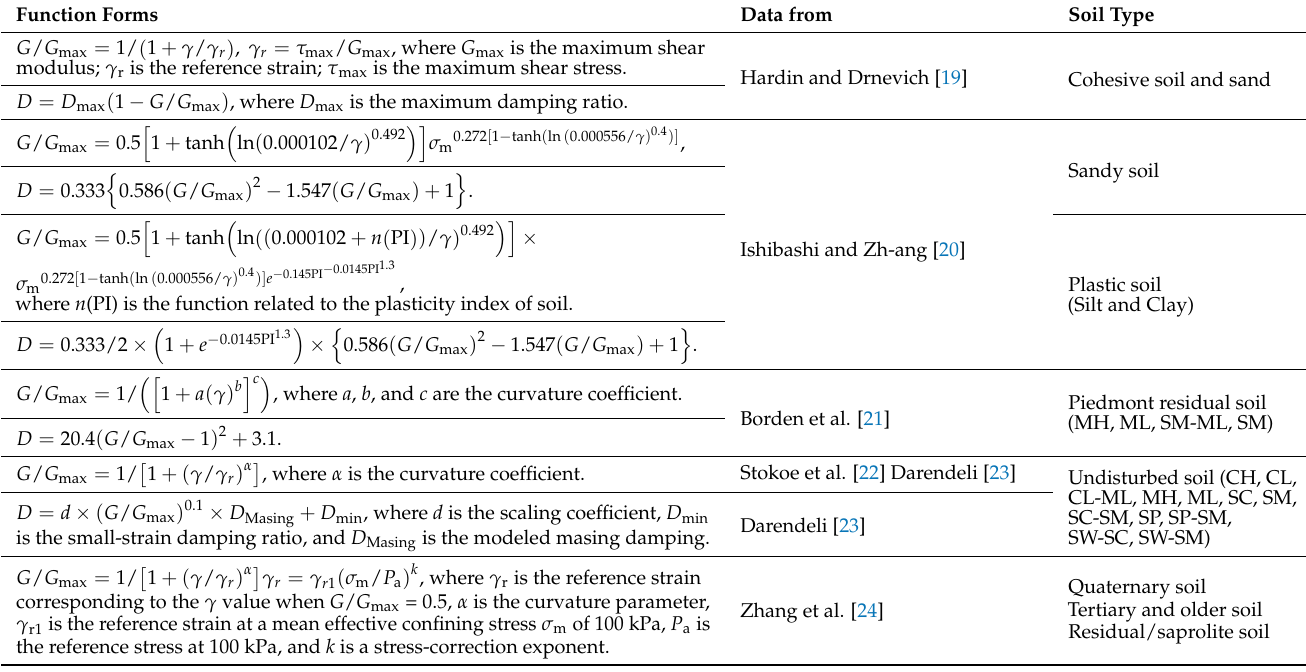
Table 1. Summary of representative G / G max – γ and D – γ function